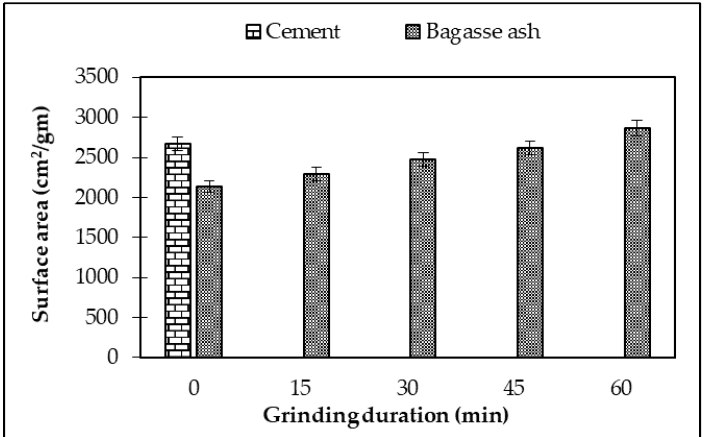
Figure 1. Comparison of SCBA surface area with cement for different grinding durations.